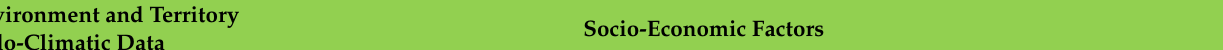
Table 3. Country region/area characterization and selection. Example of data to be